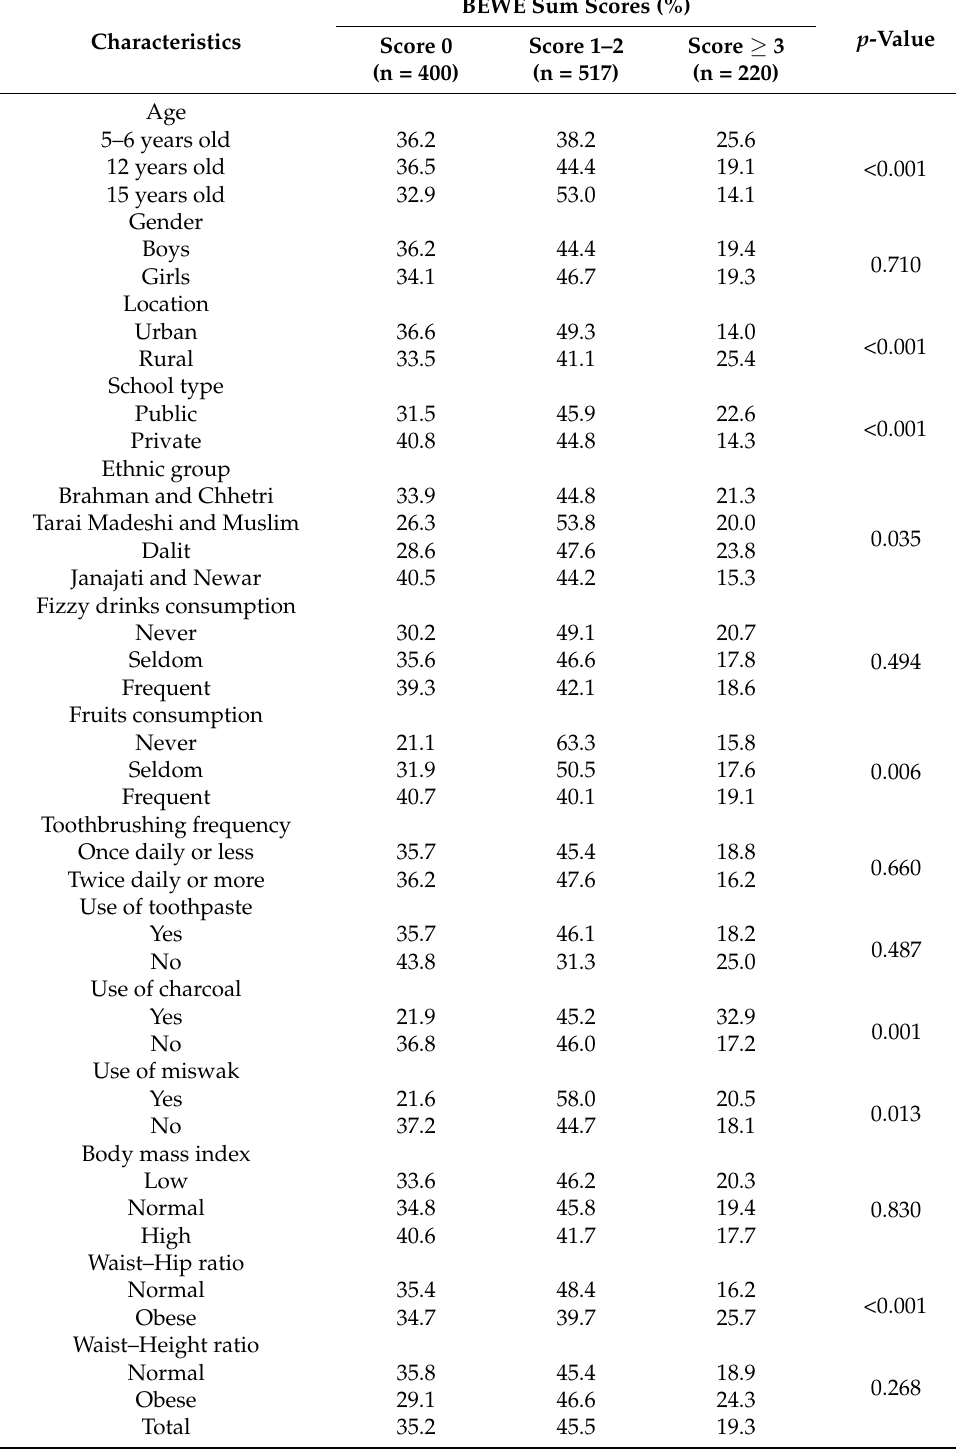
Table 2. Distribution (%) of the participants according to the Basic Erosive Wear Examination (BEWE) sum scores stratified by age, gender, location, school types, ethnic group, fizzy drinks consumption, fruits consumption, toothbrushing frequency, use of toothpaste, use of charcoal, use of miswak, body mass index, waist–hip ratio and waist–height